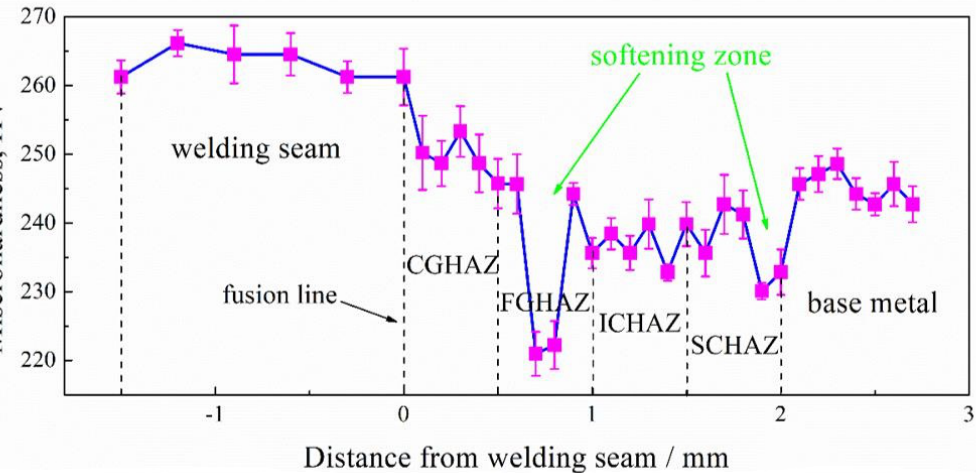
Figure 1. Schematic diagram of microhardness of actual welded